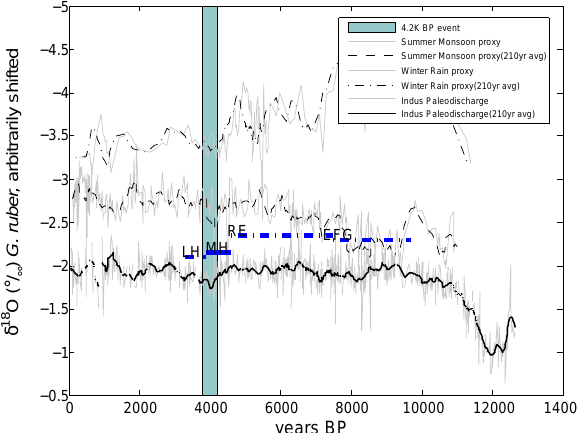
Fig. 6. The paleo-climatic proxies of the Indus River flow (Staub- wasser et al., 2003), the summer rains (Stott, 2008) and the win- ter rains (Bar-Matthews et al., 2003) over the Holocene period. Lower negative value implies lower magnitude. Also indicated is the 4200BP event. LH = Late Harappan Era, MH = Mature Harap- pan Era, RE = Regionalization era, EFG = Early Food Producing